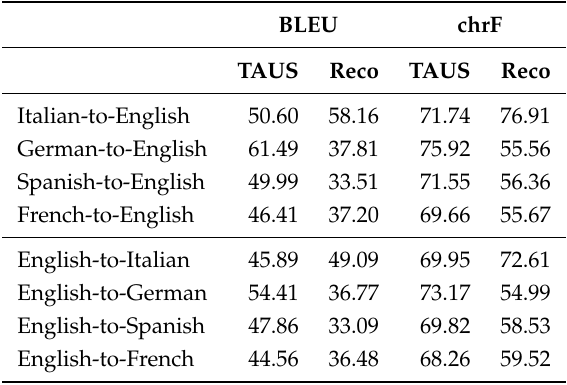
Table 7. Our improved NMT